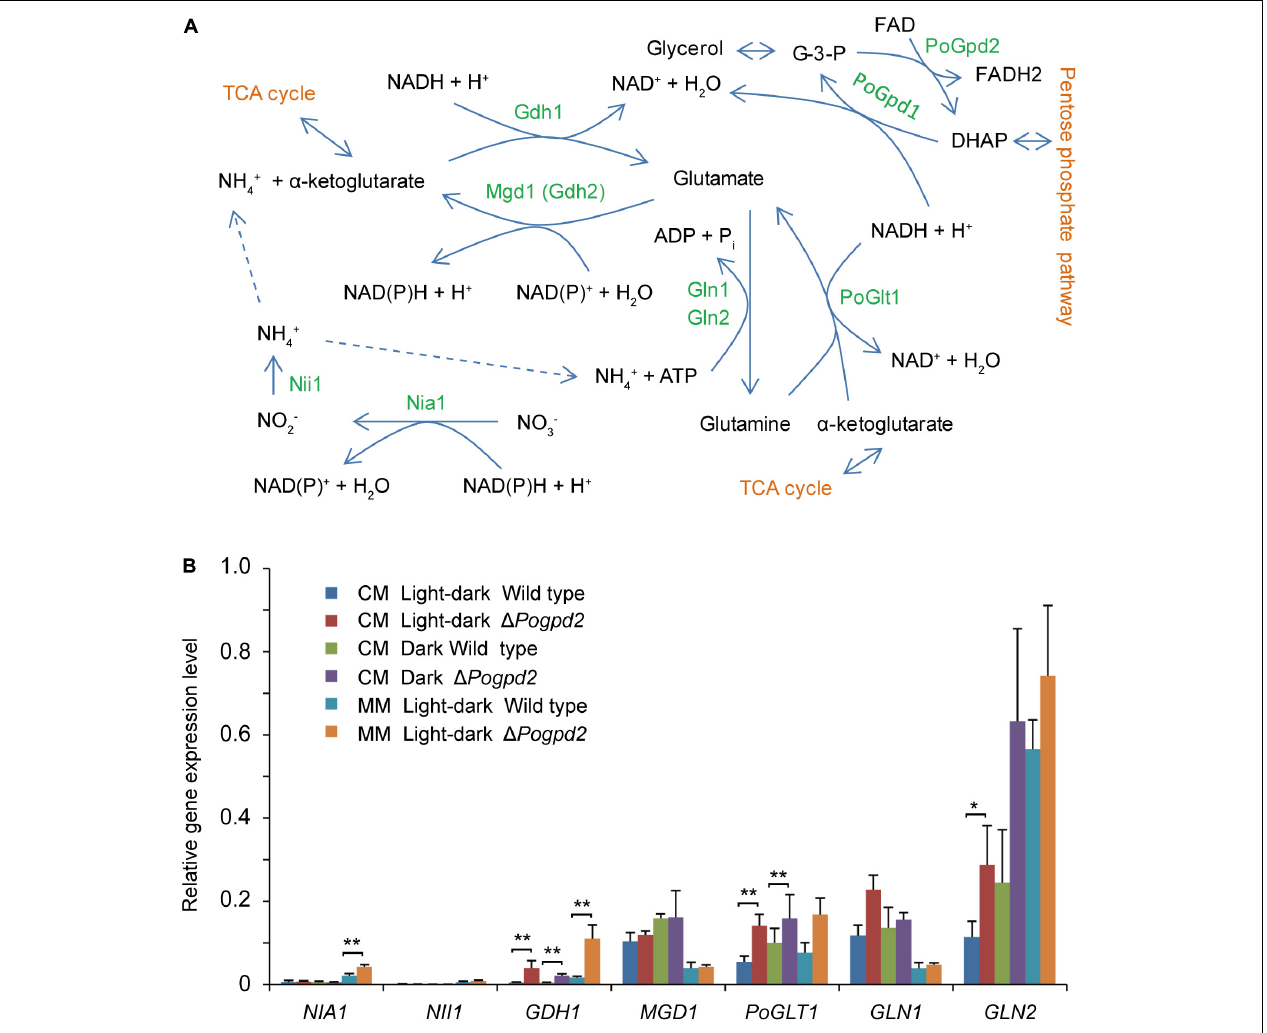
FIGURE 7 | Nitrogen assimilation in Pyricularia oryzae . (A) A pathway to assimilate nitrogen in P. oryzae . (B) Relative expression level of seven genes involved in nitrate assimilation in (cid:49) Pogpd2 cultured on CM and MM media under a light–dark cycle or a continuous dark condition. β -TUBULIN and H3 were selected as reference genes. Error bars represent SD. Significant difference compared with the wild type as estimated by Tukey’s HSD test: ∗ P < 0.05 and ∗∗ P < 0.01. TCA, Tricarboxylic acid cycle; Nia1, a nitrate reductase; Nii1, a nitrite reductase; Gdh1, a glutamate dehydrogenase; Mgd1 (Gdh2), a glutamate dehydrogenase; Gln1 and Gln2, glutamine synthetases; PoGlt1, a glutamate